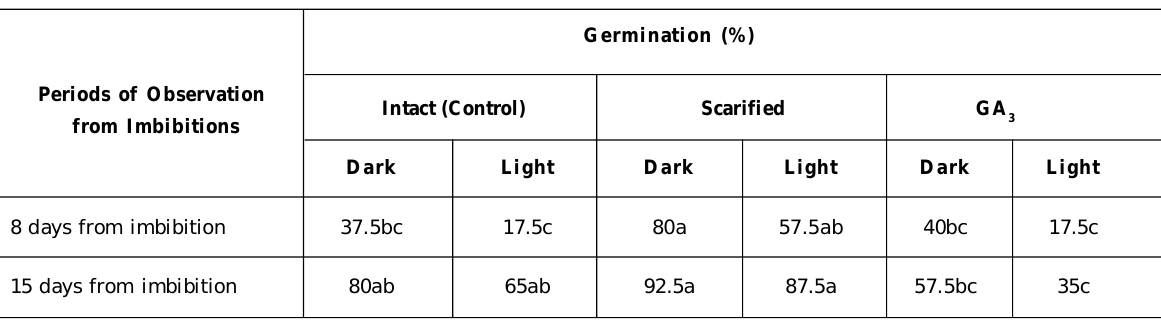
Table 1: Effect of scarification, GA imbibition on Acacia aneura